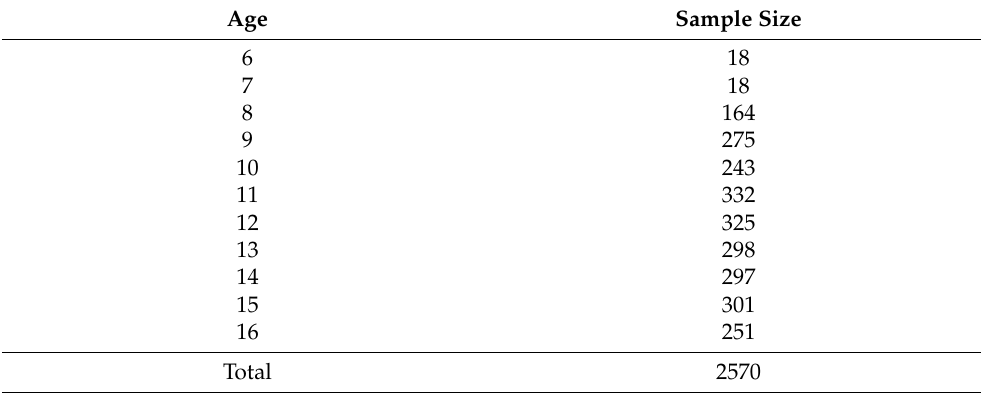
Table 1. Sample size as a function of